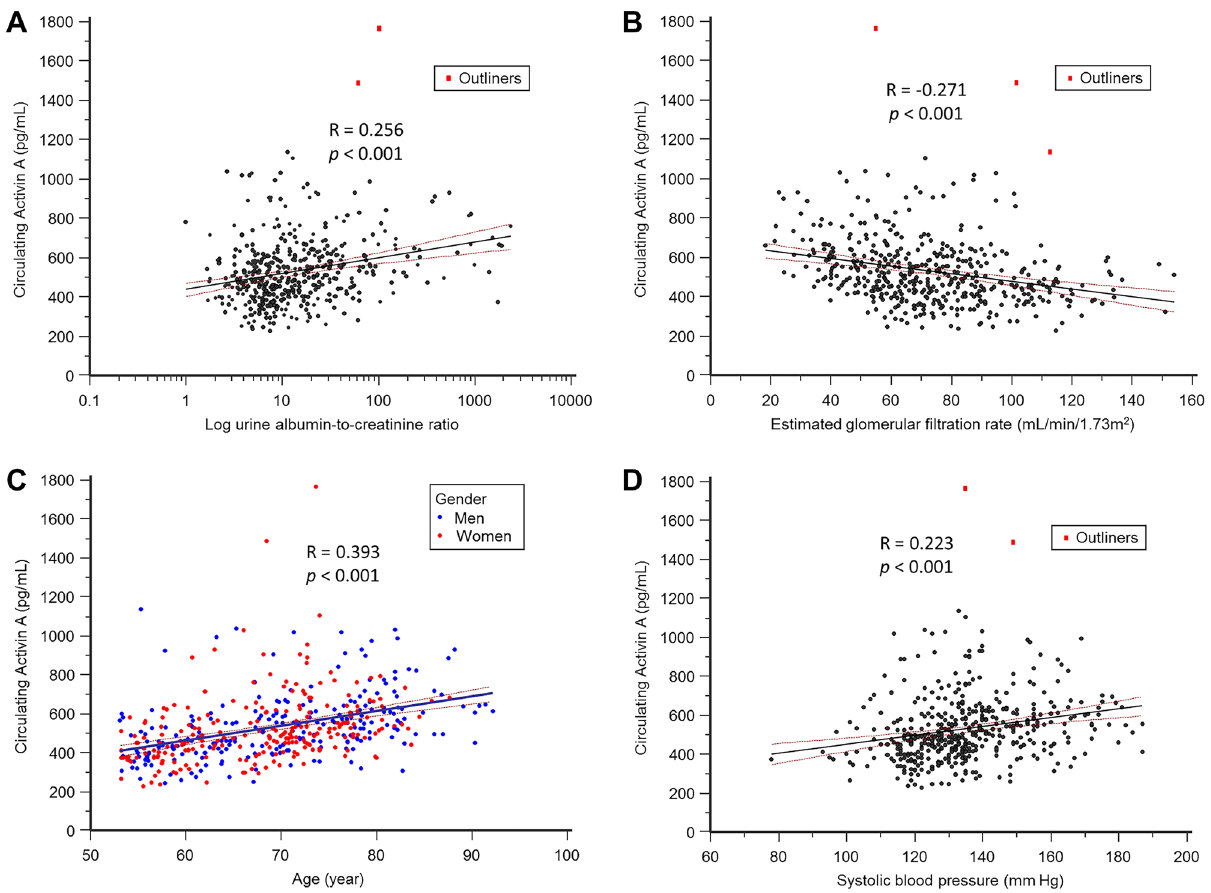
Figure 2. The elevations in circulating activin A levels are correlated to the aging-related demographic parameters.